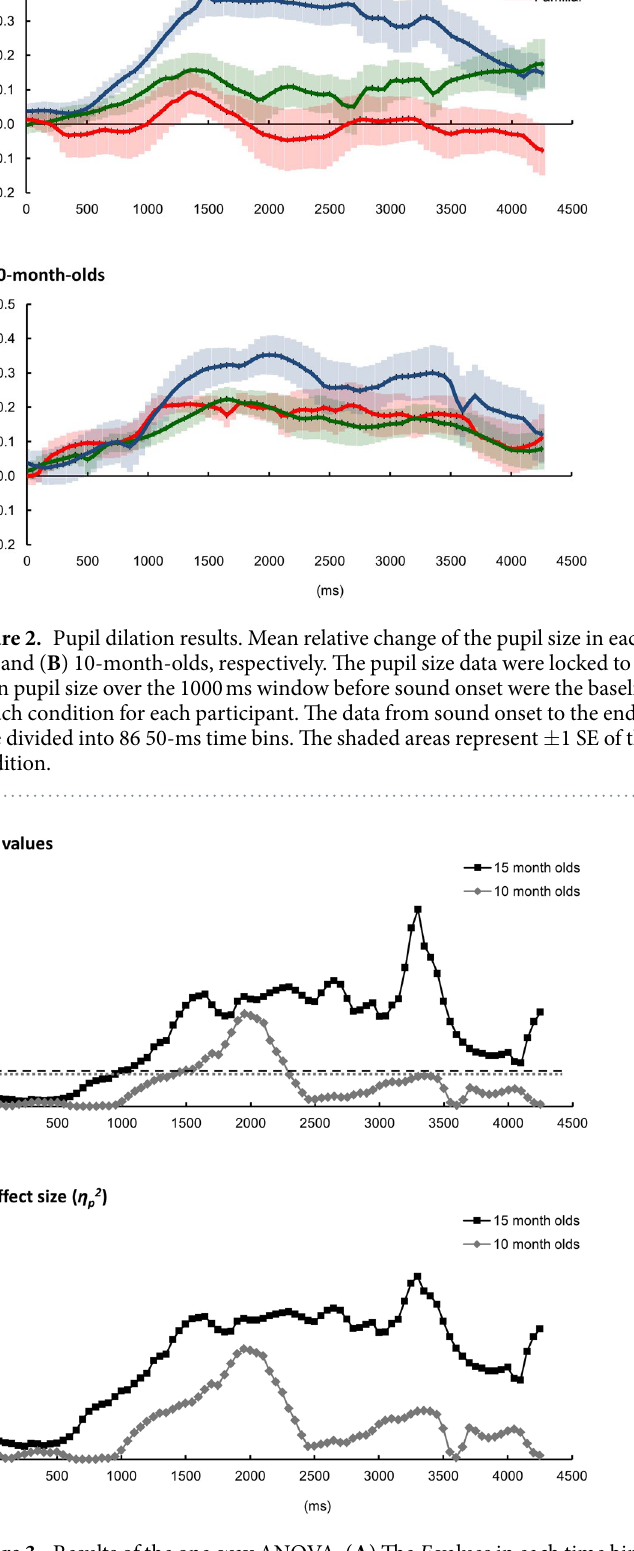
2 η ) in each time p